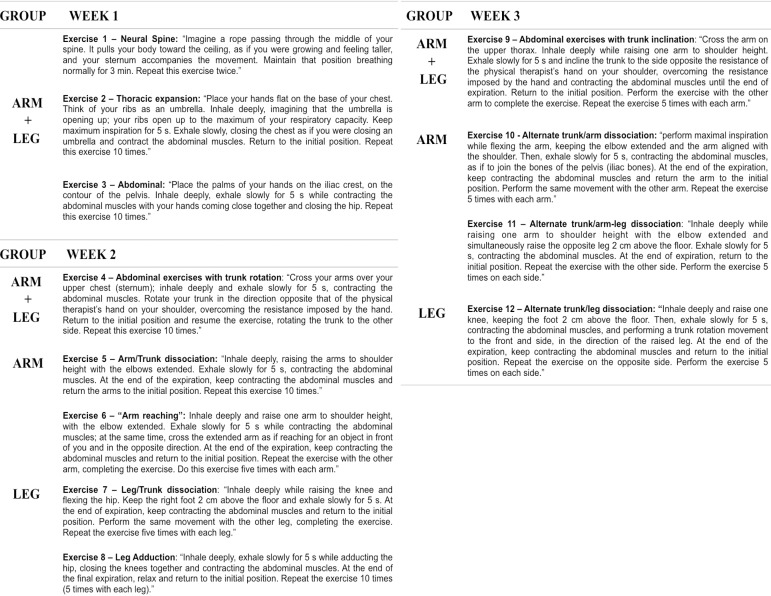
Exercise protocol.